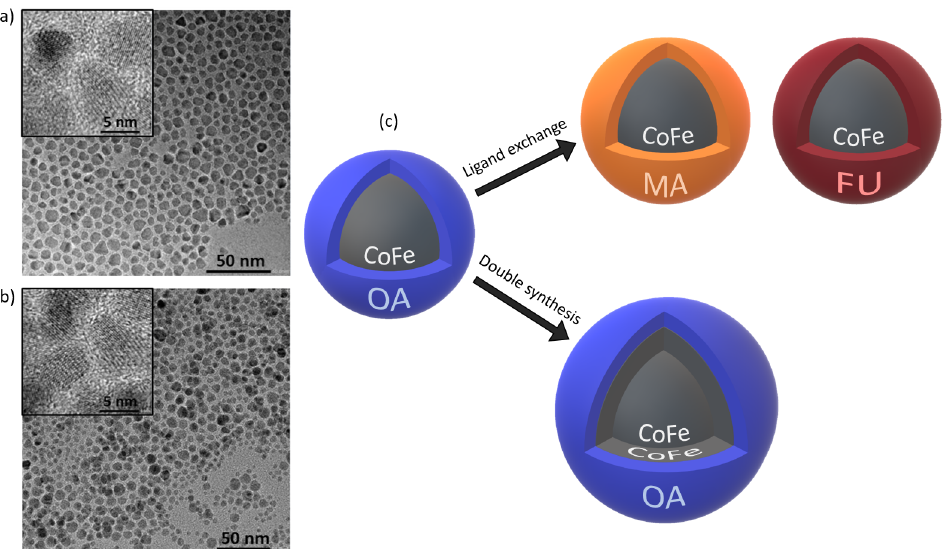
Figure 1. Representative high-resolution transmission electron microscopy (HR TEM) images of the obtained magnetic nanoparticles (MNPs) with insets showing their crystalline structure, for the one- step ( a ) and two-step ( b ) hydrothermal synthesis. Relative disorder difference is due to the 50% seed MNP usage in the two-step synthesis process. Panel ( c ) presents the synthesis and functionalization strategy for the MNPs used in the study. The initial MNPs covered with OA were either functionalized with MA or FU. As an alternative, the two-step process yields MNPs with larger size via synthesis on top of the initial cobalt ferrite core